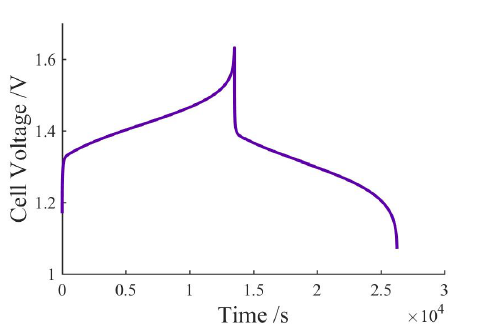
Figure 2. Simulated theoretical cell voltage of a VRFB between 1% and 99%